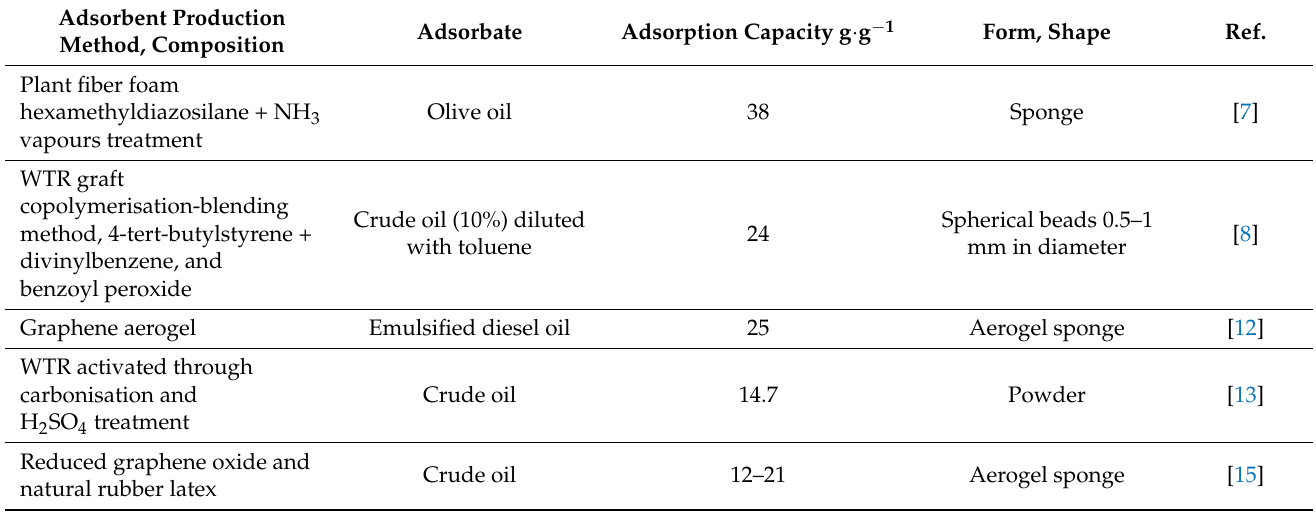
Table 1. Examples of developed and studied sorbents for crude oil and oil products’ spill clean-up and water